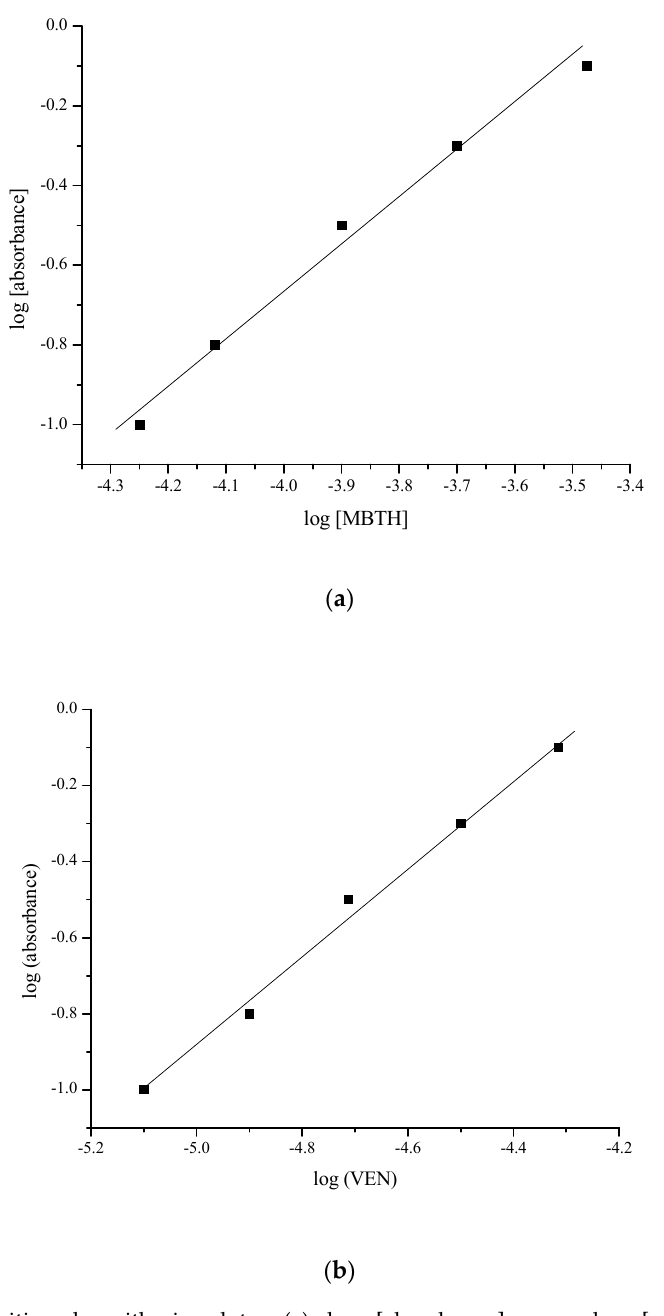
Figure 5. Limiting logarithmic plot: ( a ) log [absorbance] vs. log [concentration of 3-methyl-2-benzothiazolinone hydrazone hydrochloride (MBTH)]; ( b ) log [absorbance] vs. log [concentration of VEN].